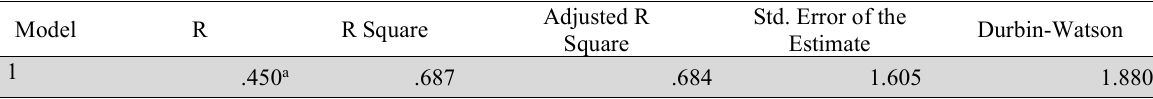
Adjusted R Std. Error of the Durbin-Watson Square Estimate